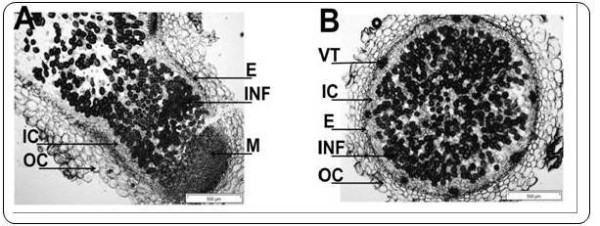
Longitudinal (A) and cross section (B) through a chickpea nodule. Abbreviations: (INF) Infected zone, (NP) Nodule parenchyma, (E) Endodermis, (NC) Nodule cortex, (VT) Vascular trace, (IC) Inner cortex, (OC) Outer cortex, (M) Meristem